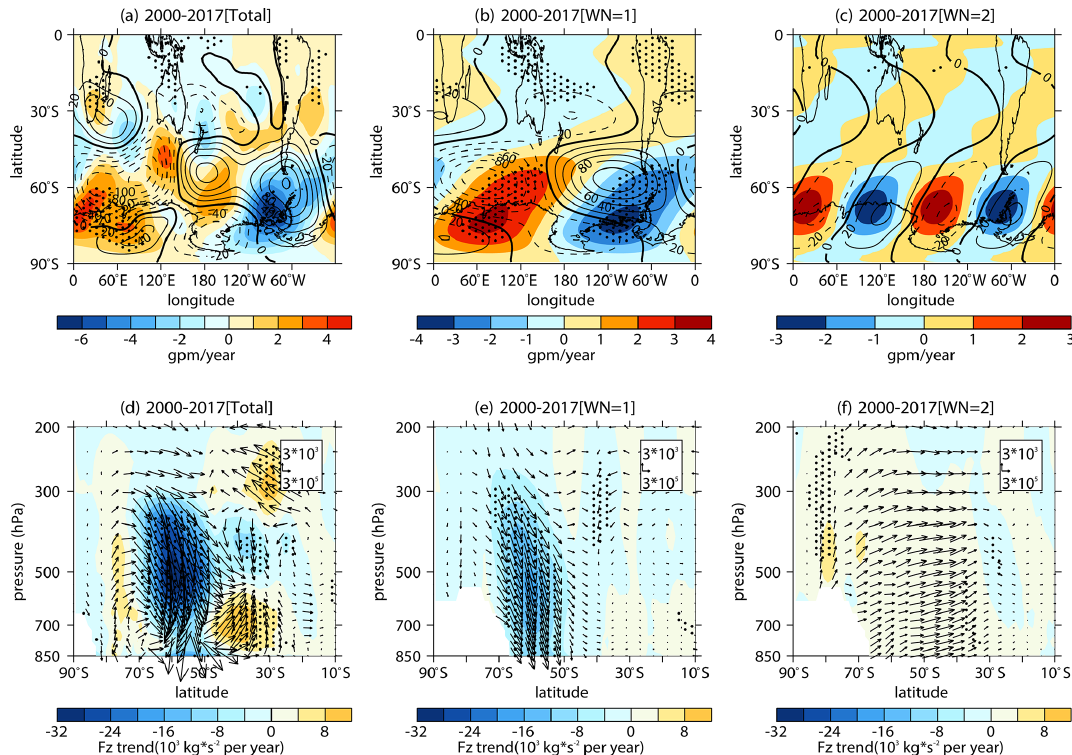
Figure 3. Trends (shading) and climatological distributions (contours with an interval of 20gpm (geopotential meters); positive and negative values are depicted by solid and dashed lines, respectively; zeroes are depicted by thick solid lines) of southern hemispheric (a) 500hPa geopotential height zonal deviations, with their (b) wave 1 component and (c) wave 2 component in September during 2000–2017, as derived from the MERRA-2 dataset. Trends of the southern hemispheric (d) tropospheric E–P flux (arrows; units of horizontal and vertical components are 3 × 10 5 and 3 × 10 3 kgs − 2 yr − 1 , respectively) and its vertical component (shading), with their (e) wave 1 component and (f) wave 2 component in September during 2000–2017, as derived from the MERRA-2 dataset. The stippled regions represent the trend significant at/above the 90% confidence